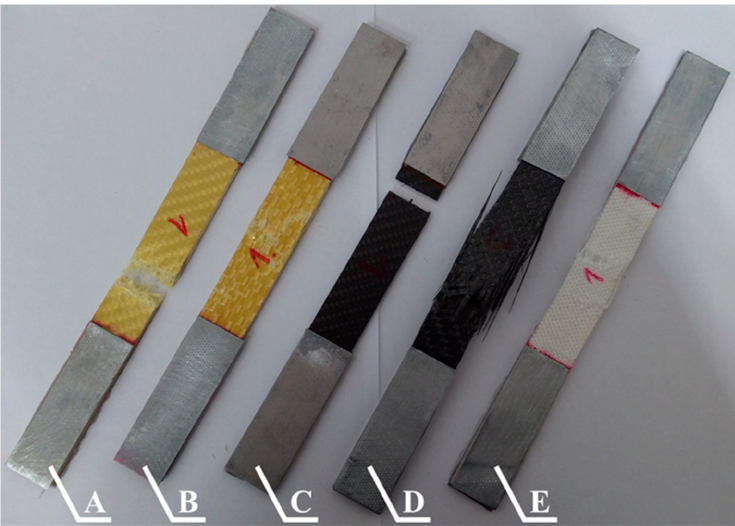
Figure 15. Selected epoxy composites samples with reinforcement made from the following